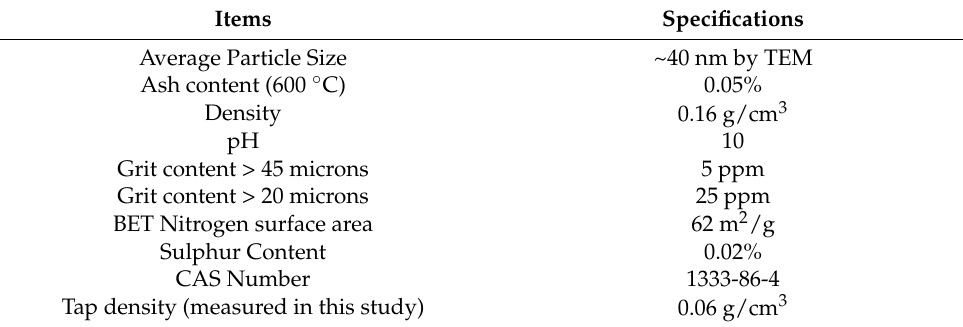
Table 1. Manufacturer’s specifications of raw carbon blacks